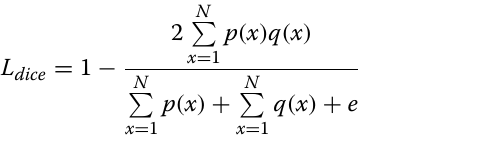
Table 2 Parameter values of the proposed